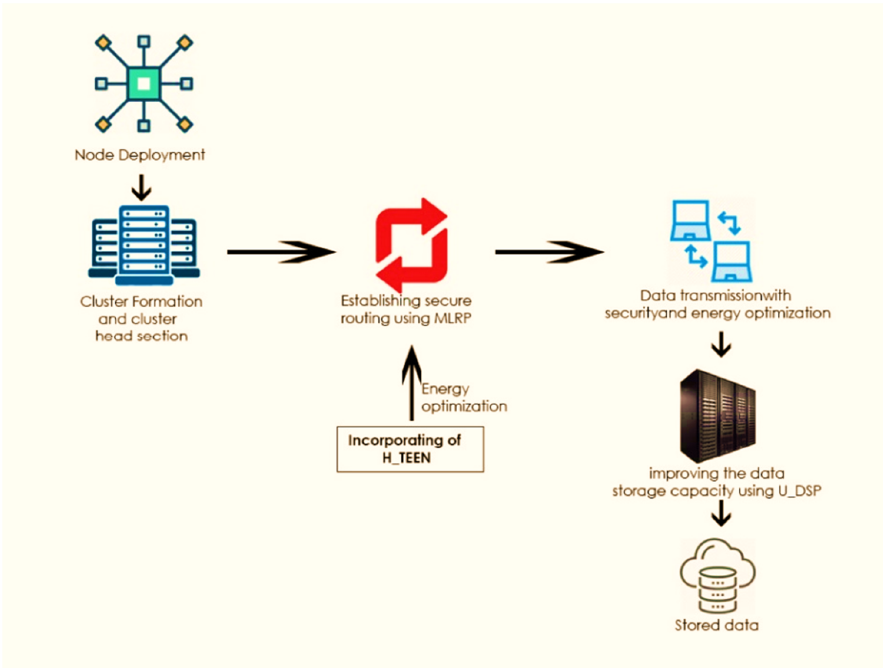
Figure 1. Proposed